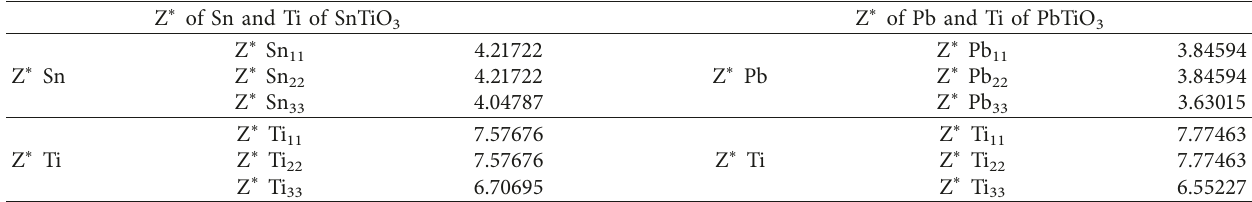
3 and PbTiO 3 in the ferroelectric phase.